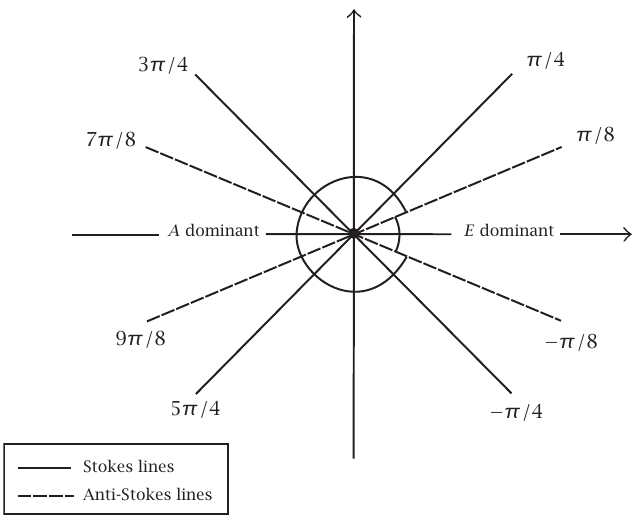
Figure 2.3 . The Stokes lines are shown for the exponential term in (2.19a) corresponding to µ = 1 / 4. Also shown is the sector E where the exponential term in (2.19a) dominates and the sector A where the algebraic term in (2.19)